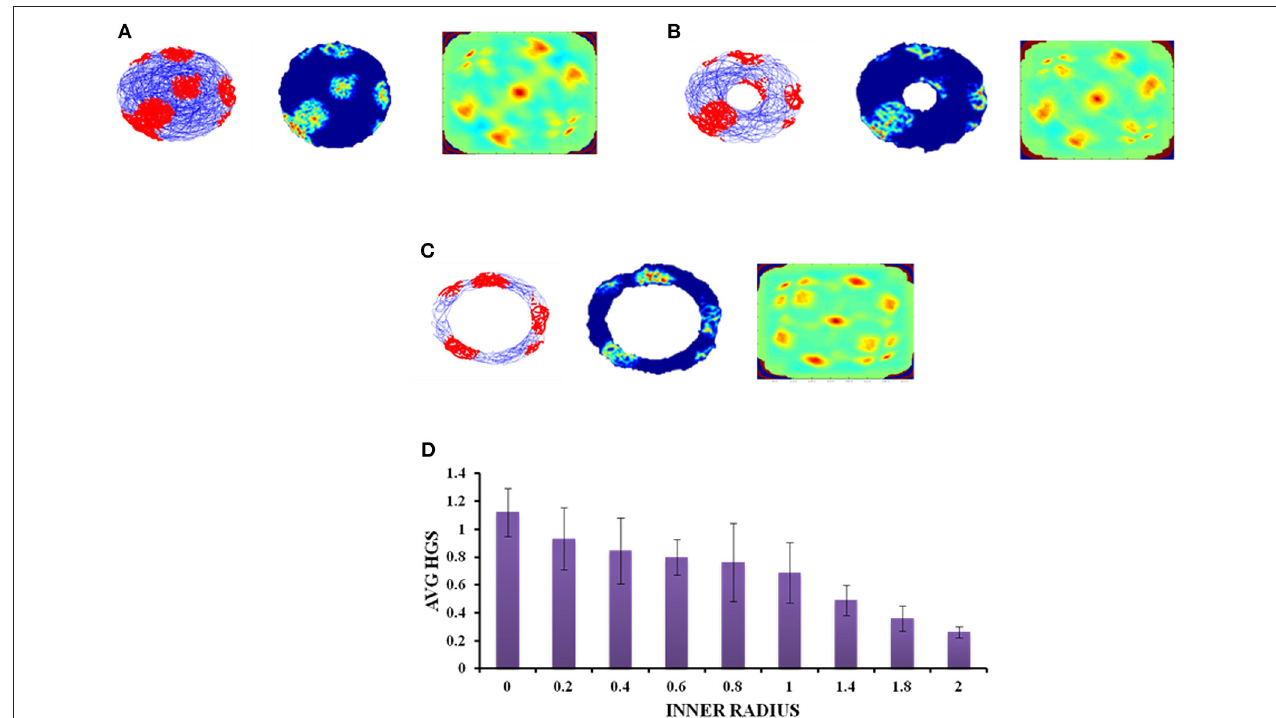
FIGURE 7 | Grid cell response in annulus shaped environment. (A–C) Firing field, firing rate, and auto correlation maps of grid activity in the annulus environment with varying inner radii of 0, 0.8, and 2, respectively. (D) Average HGS values vs. varying inner radii of